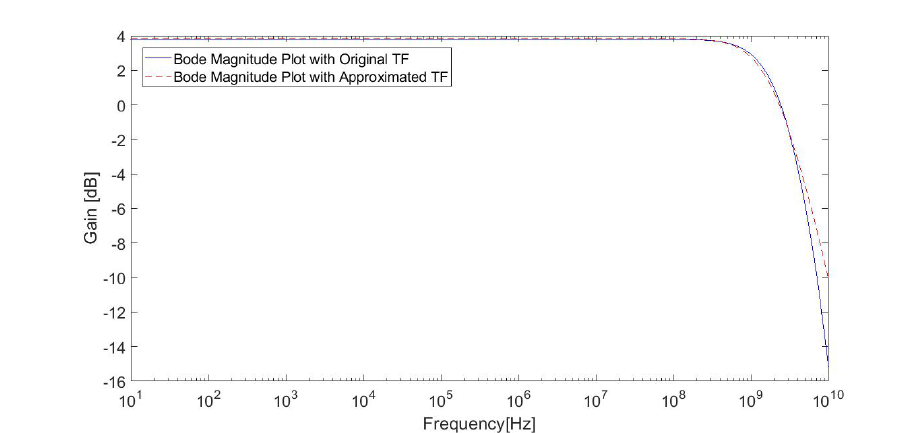
Figure 3. Bode magnitude of the current-mode logic stage shown in Figure 1, simulated using CMOS technology of 180 nm, and comparing the original TF versus the symbolic